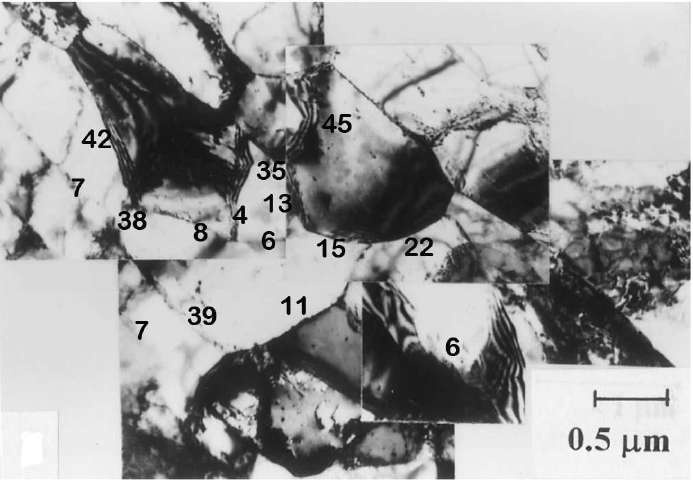
Figure 4. UFG microstructure in microshear band in a Fe-25%Cr steel after compression to a strain of 1.05 at 873 K. Numbers indicate the boundary misorientations in degrees. Reproduced from [59], with permission from Springer Nature, 2023.